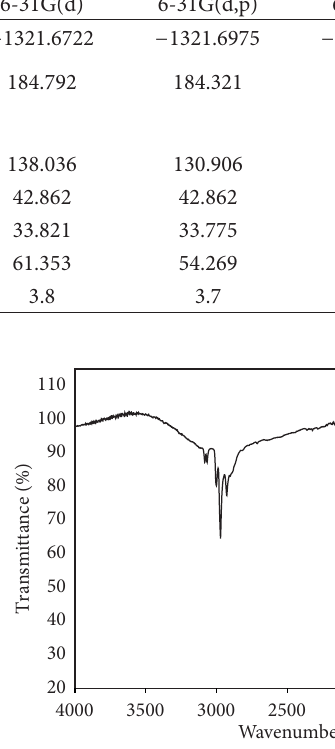
T 4: eoretically computed energies, zero-point vibrational energies, entropies and dipole moment for the title compound. ermodynamic parameter